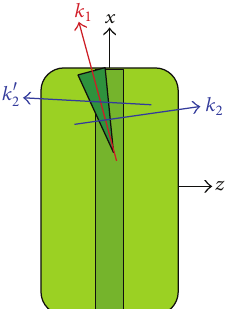
Figure 3: A sketch of initial configuration in 𝑥 - 𝑧 plane at early time. Horizontal thickness of the medium is Δ𝑧 ∼ 2 fm; the inner vertical slab indicates the relative thickness ( ∼ 0.5fm) of the overlapping contracted disks in which the valence quarks are restricted. Red arrow represents semihard parton surrounded in medium by a cone of enhanced thermal partons. Blue arrows represent soft partons with 𝑘 𝑖 ≲ 2 GeV/c that originate from outside the slab and can therefore interact with the cone (color